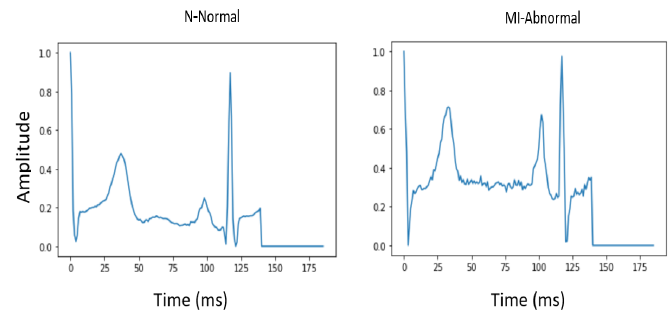
Figure 4. Sample plots of heartbeats of two classes for PTB dataset.